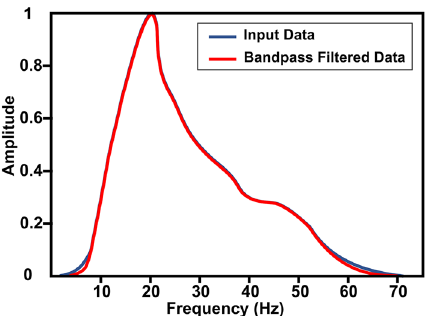
Fig. 5 An amplitude Spectrum, before bandpass filter (blue curve) and after bandpass filter (red curve), showing that the extreme low and high frequencies are eliminated without distorting the main sig- nals